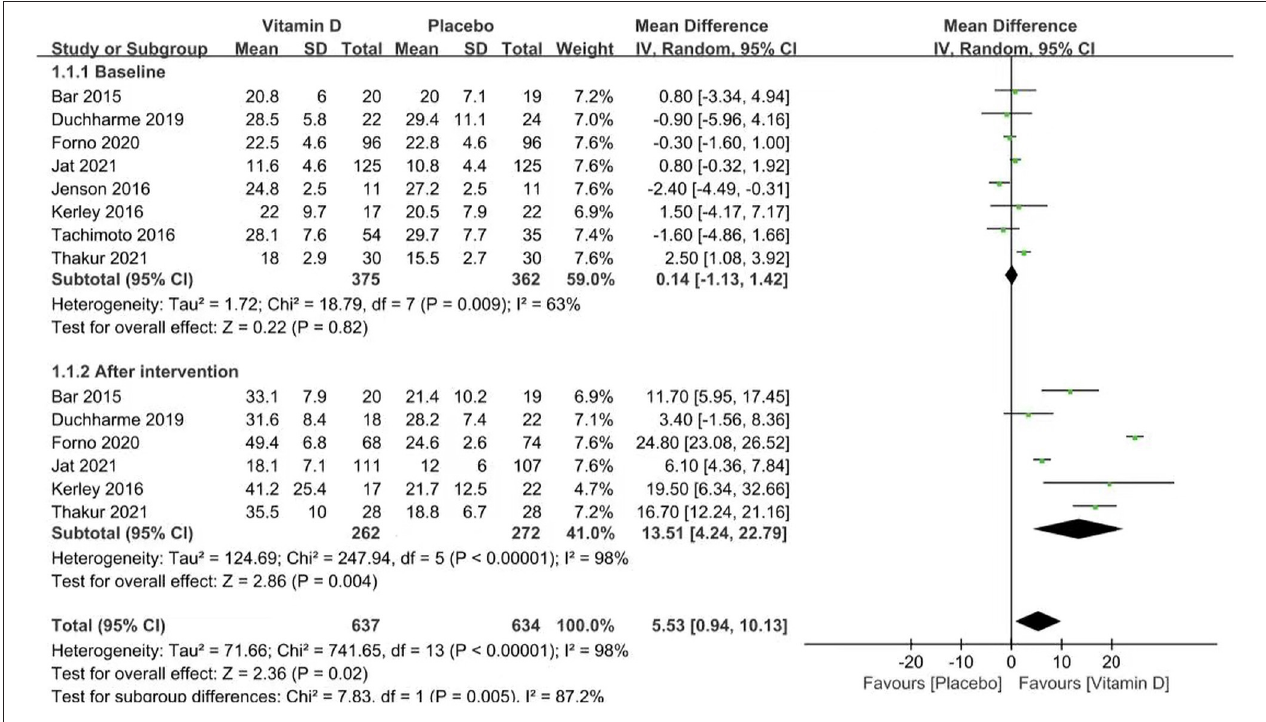
FIGURE 2 | Forest plots of MD of vitamin D levels associated with vitamin D vs. placebo.